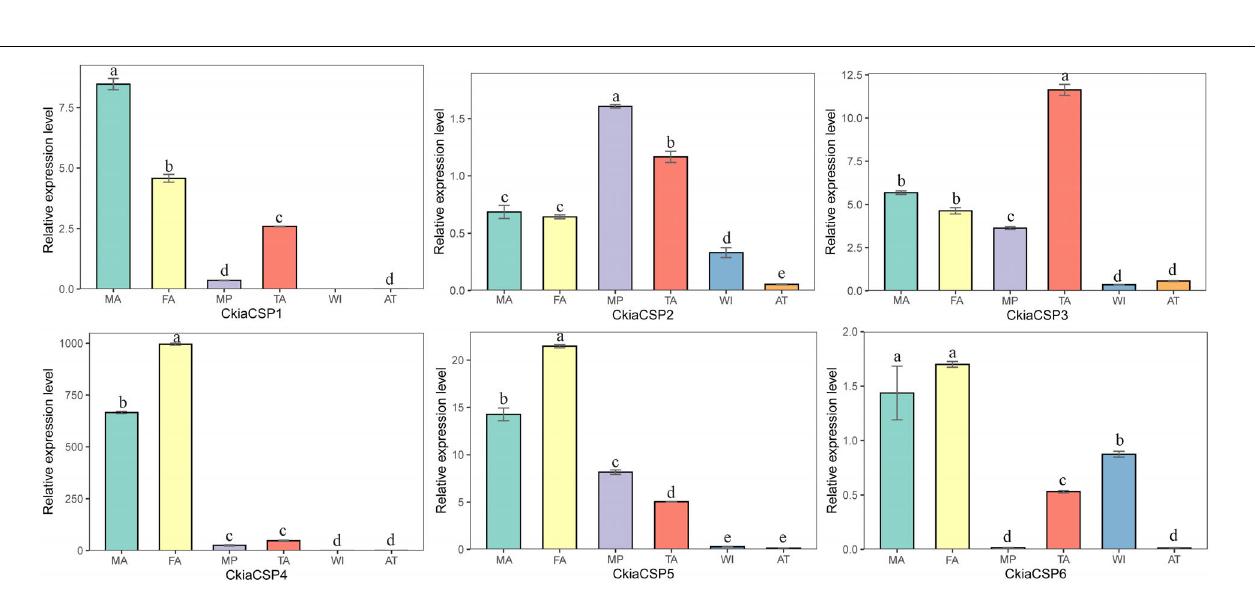
FIGURE 9 | Relative expression levels of OBPs in different tissues of C. kiangsu as measured by RT-qPCR. FA, female antennae; MA, male antennae; MP, maxillary palps; TA, tarsi; WI, wings; AT, thoraxes-abdomens. The bar represents standard error and the different small letters above each bar indicate significant differences ( P < 0.05).